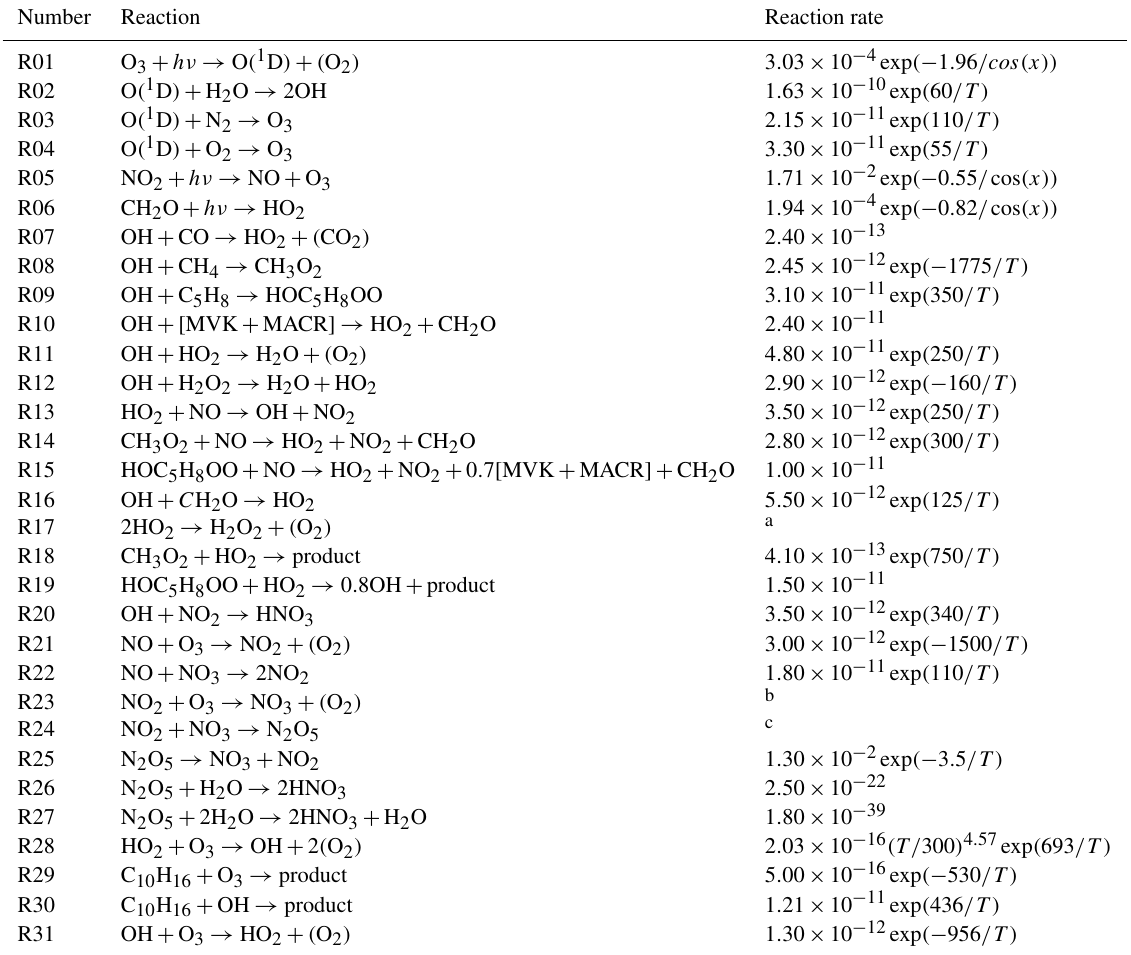
Table 4. The reduced chemistry scheme used in MXLCH. Product compounds shown in parentheses (e.g., (O 2 )) indicate that these are not included in the model